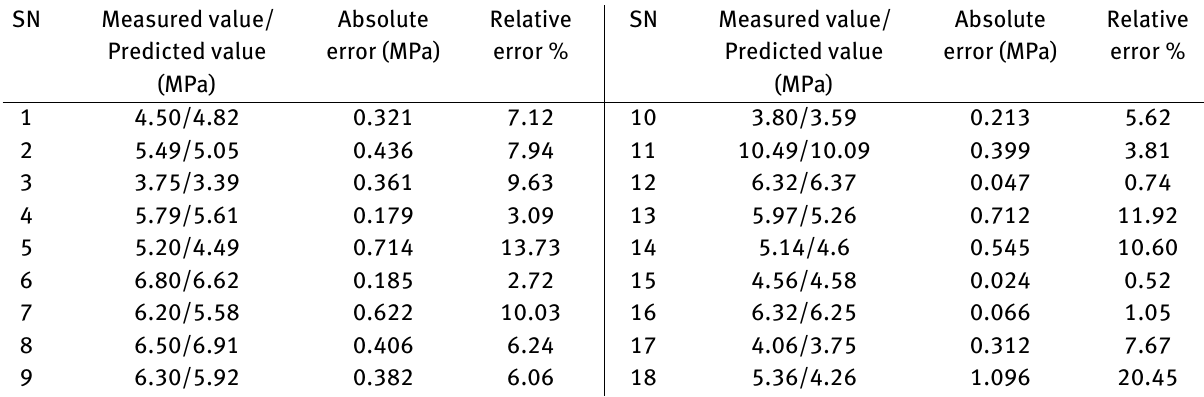
Absolute error (MPa)